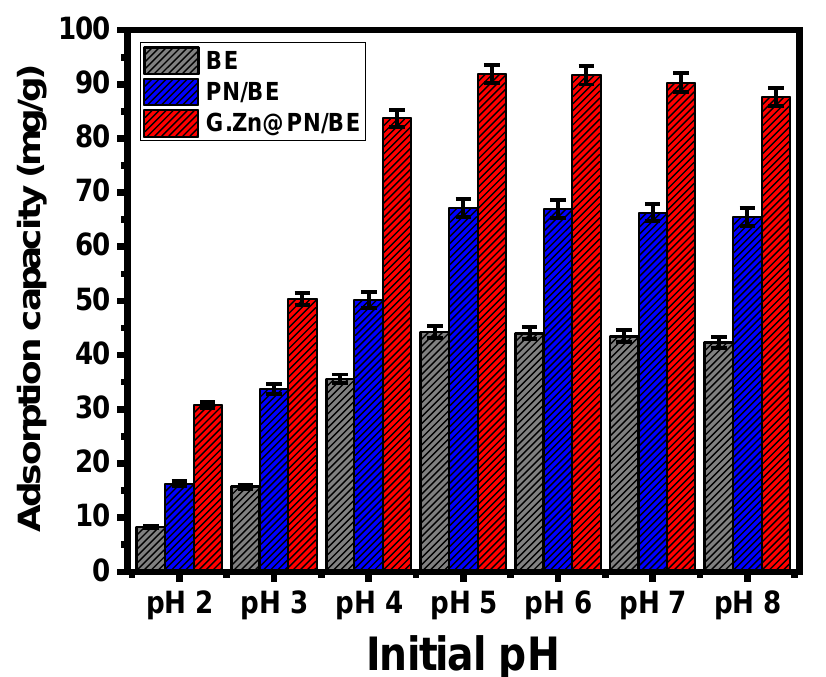
Figure 4. The influence of pH on the retention of As (V) ions by BE, PN/BE and G.Zn@PN/BE composite.